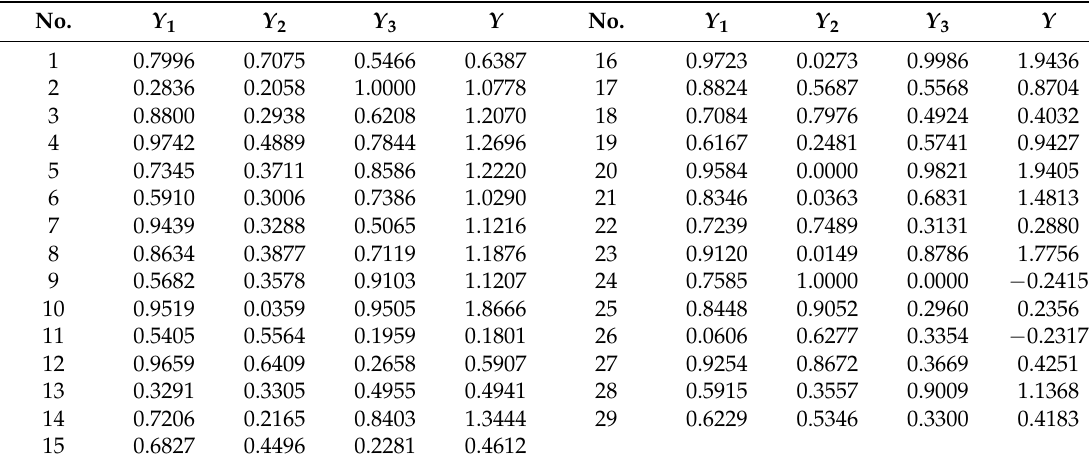
Table 4. Box–Behnken design for independent variables and observed responses.